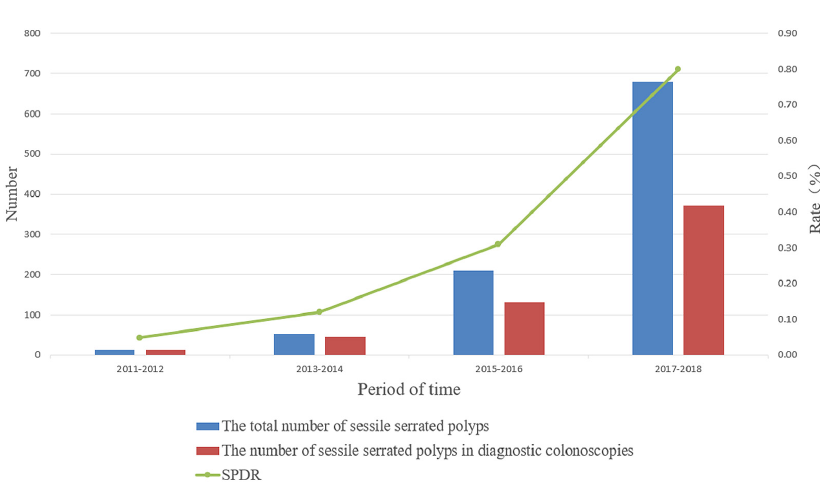
Figure 1. The number of sessile serrated polyps (SSP) detected and the SSP detection rate (SSPDR) in different periods of time.